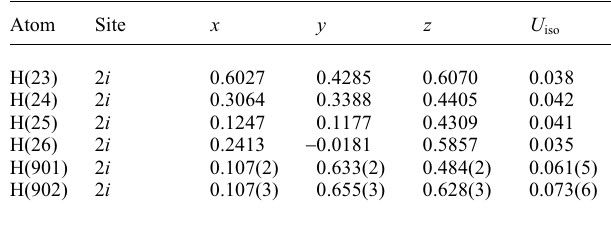
Table 2. Atomic coordinates and displacement parameters (in Å 2 )